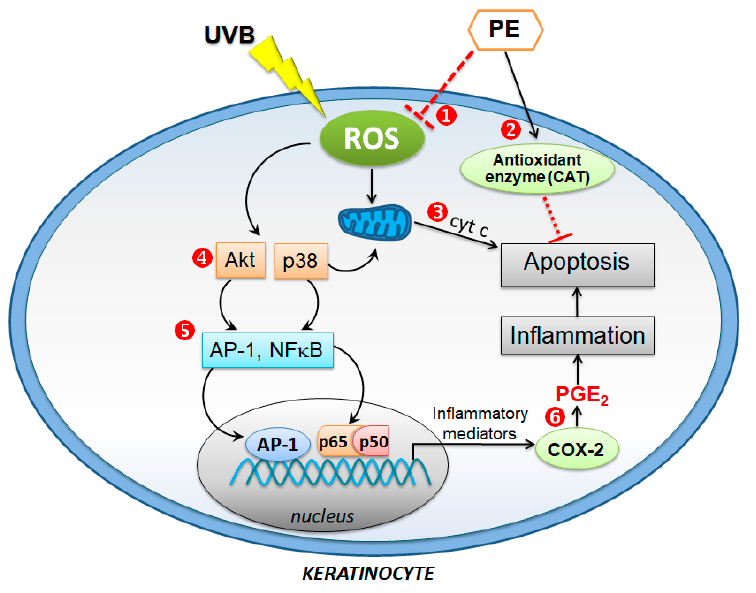
Figure 7. Schematic diagram depicting the proposed mechanisms of PE cytoprotection against UVB- induced HaCaT cell inflammation and apoptosis. ❶ The antioxidant effects of PE predominantly reduced ROS generation, particularly hydrogen peroxide generation, and ❷ the endogenous anti- oxidant defense enzyme CAT was activated. ❸ PE inhibited cyt c release. While PE had no impact on p38-induced apoptosis, it inhibited the dysregulation of PI3K/Akt ❹ , which partakes in the bal- ance of signaling pathways toward cell survival or apoptosis. PE attenuated the inflammatory re- sponse to UVB irradiation via the inhibition of the inflammatory signaling of ❺ AP-1, NF- κ B, and the mediator ❻ PGE 2 .